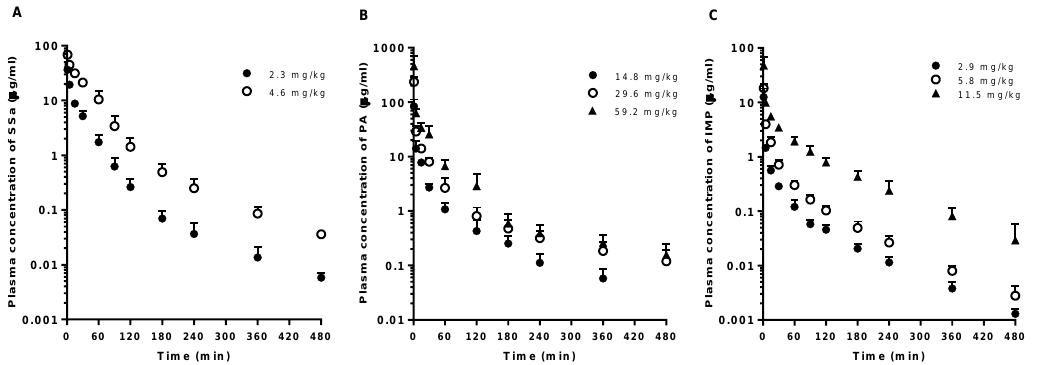
Figure 2. Mean arterial plasma concentration-time profiles of ( A ) SSa, ( B ) PA, and ( C ) IMP following 1-min intravenous administration of each pure compound at various doses (2.3 ( n = 5) and 4.6 ( n = 4) mg/kg of SSa; 14.8 ( n = 5), 29.6 ( n = 5), and 59.2 ( n = 6) mg/kg of PA; and 2.9 ( n = 5), 5.8 ( n = 6), and 11.5 ( n = 5) mg/kg of IMP) to rats. Vertical bars represent SD.